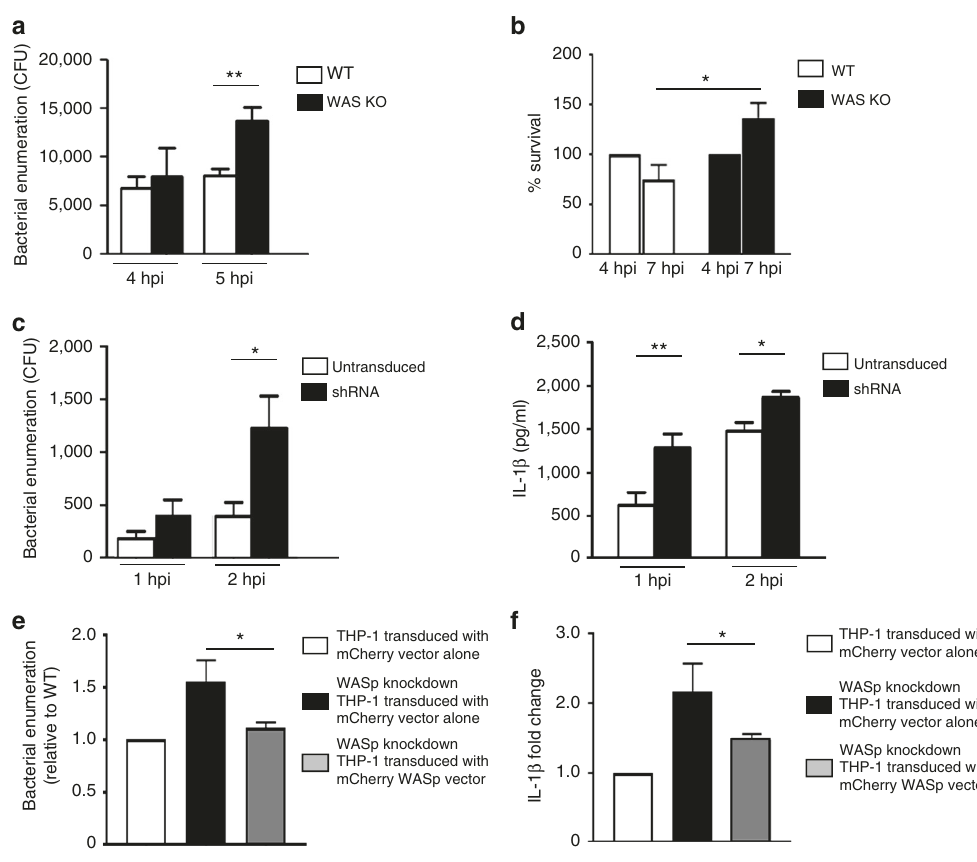
Fig. 3 WAS de fi ciency leads to defective bacterial clearance. a BMDCs were co-cultured with WT EPEC (MOI of 5) for 2 or 3 h, followed by a 2 h gentamicin (100 µ g/ml) treatment. At 4 or 5 hpi, intracellular live bacteria were enumerated. Data presented are mean CFU ± SEM of three independent experiments in duplicates. Two-sided Student ’ s t -test. b BMDCs were co-cultured with WT EPEC (MOI of 5) for 2 h, followed by a 2 h gentamicin treatment. Intracellular bacteria were enumerated and CFU at this time-point (4 hpi) were considered 100%. In parallel, gentamicin (50 µ g/ml) treatment was allowed to continue for an additional 3 h (total 7 hpi) before enumeration. Data represent mean percentage CFU ± SEM of three independent experiments in duplicates at 4 and 7 hpi. Two-sided Student ’ s t -test. c Transduced THP-1 cells were co-cultured with S. fl exneri M90T for 30 min (MOI of 1) prior to gentamicin treatment for 30 or 90 min. Intracellular live bacteria were enumerated at 1 or 2 hpi. Data represent mean ± SEM of three independent experiments in duplicates. Two-sided Student ’ s t -test. d Untransduced WT or WASp shRNA THP-1 cells were co-cultured with S. fl exneri M90T for 1 or 2